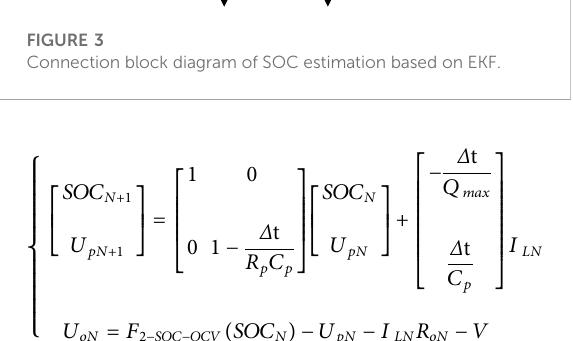
FIGURE 4 Non-constant discharge current.